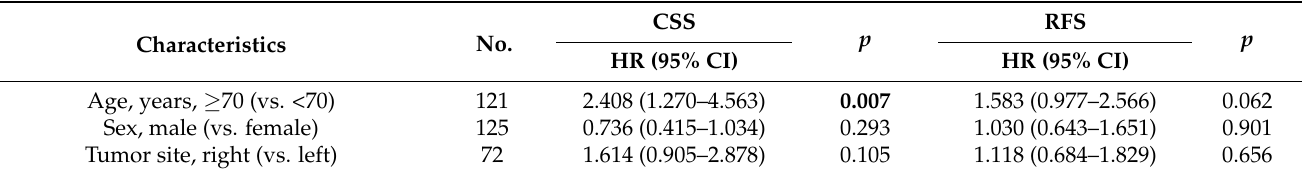
Table 2. Univariate Cox proportional hazards regression analysis for cancer-specific survival and relapse-free survival in 122